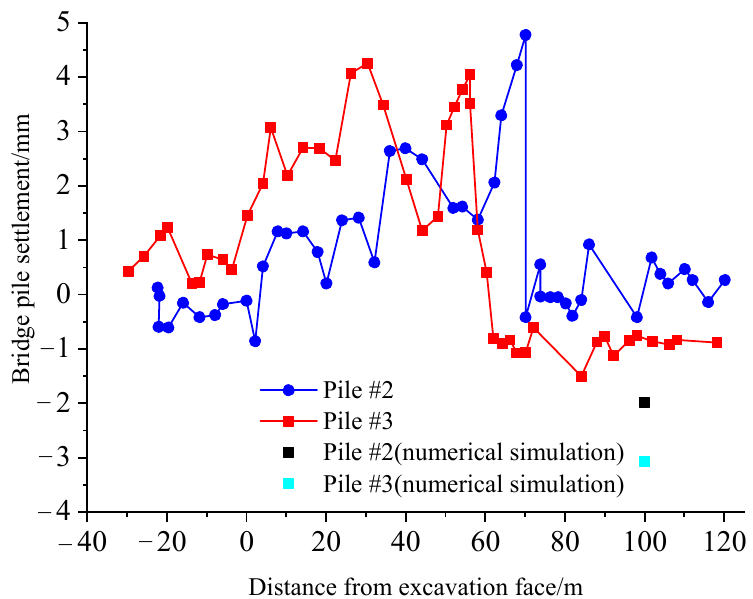
Figure 12. Vertical displacement of bridge piles.